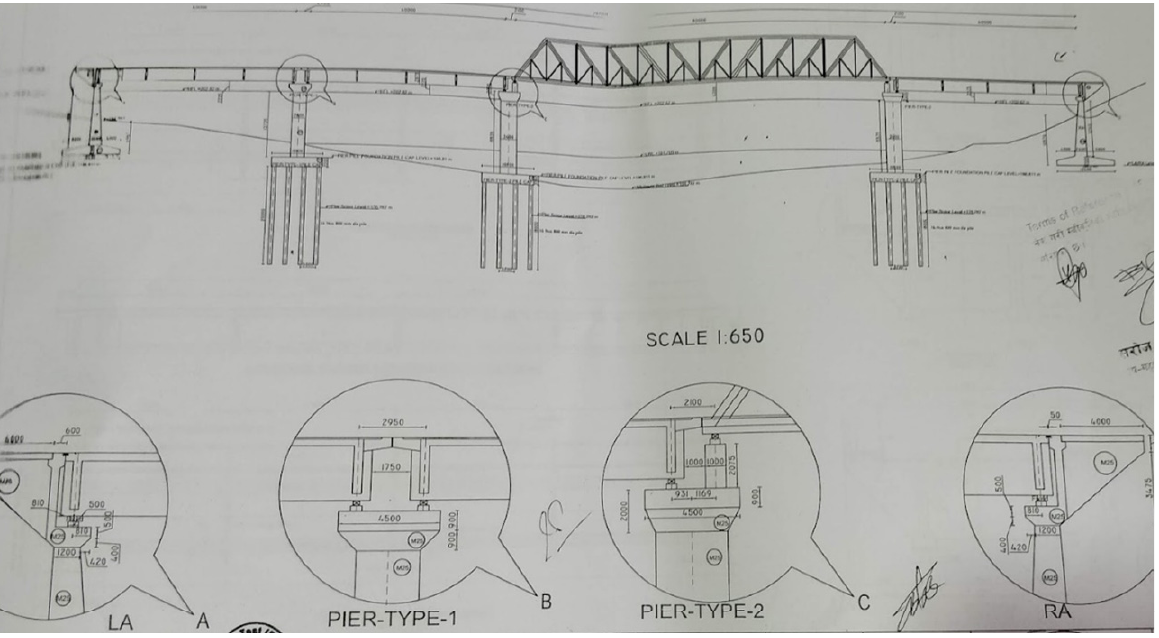
Figure 1. Schematic details of the bridge (generously shared by Department of Roads, Chitwan Division, Nepal).